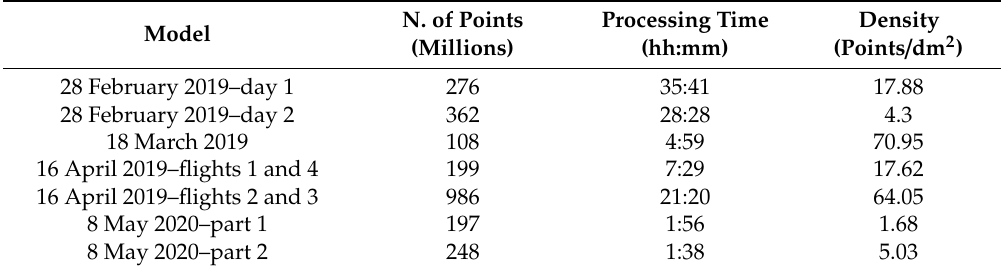
Table 4. Statistical information about dense point clouds